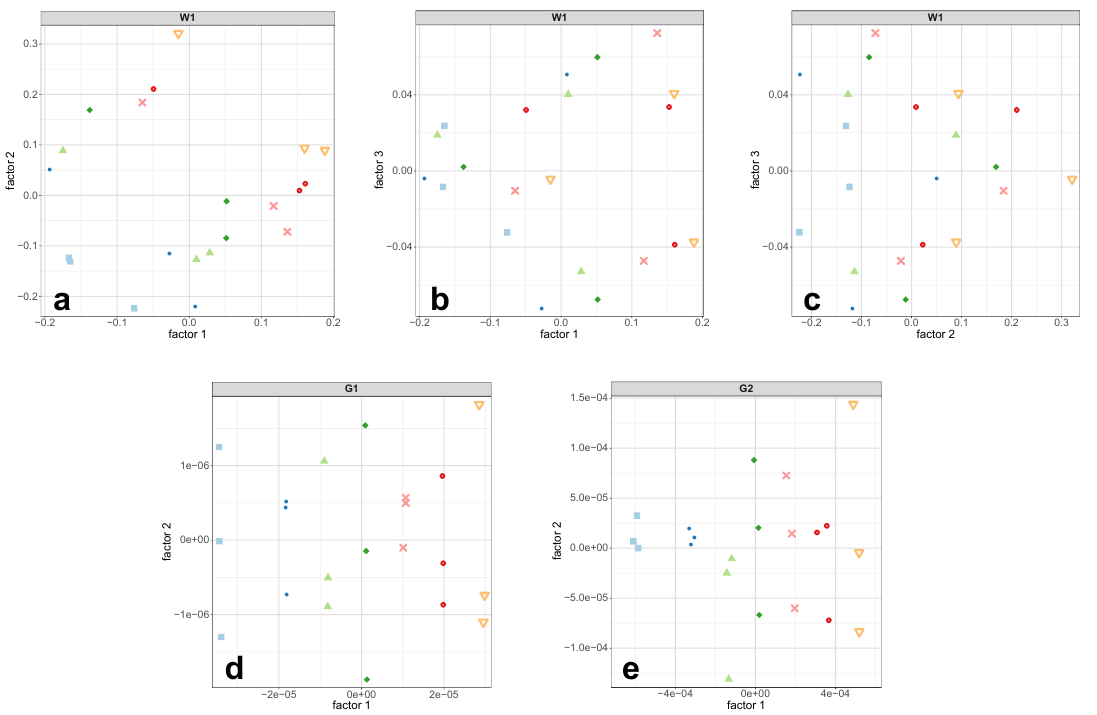
Figure 8. PLS-R score plots of the calibration set for the regions W1 ( a – c ), G1 ( d ), and G2 ( e ) obtained by measurements with the 2 mm cell. Each data point corresponds to one batch. The featured factors were chosen according to the required number of PLS-R factors in Table